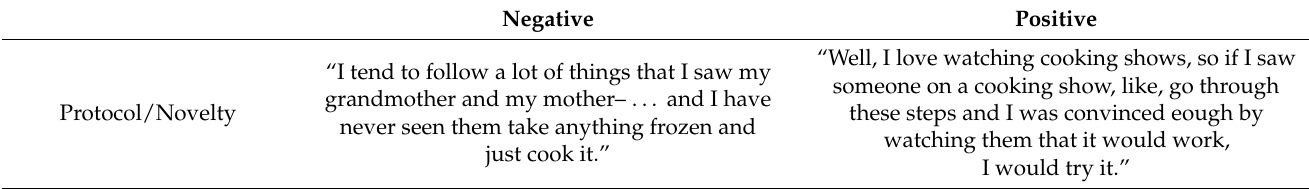
Table 5. Attitudes toward cooking direct-from-frozen seafood before the introduction of recipes. Focus group, illustrative quotes. Negative